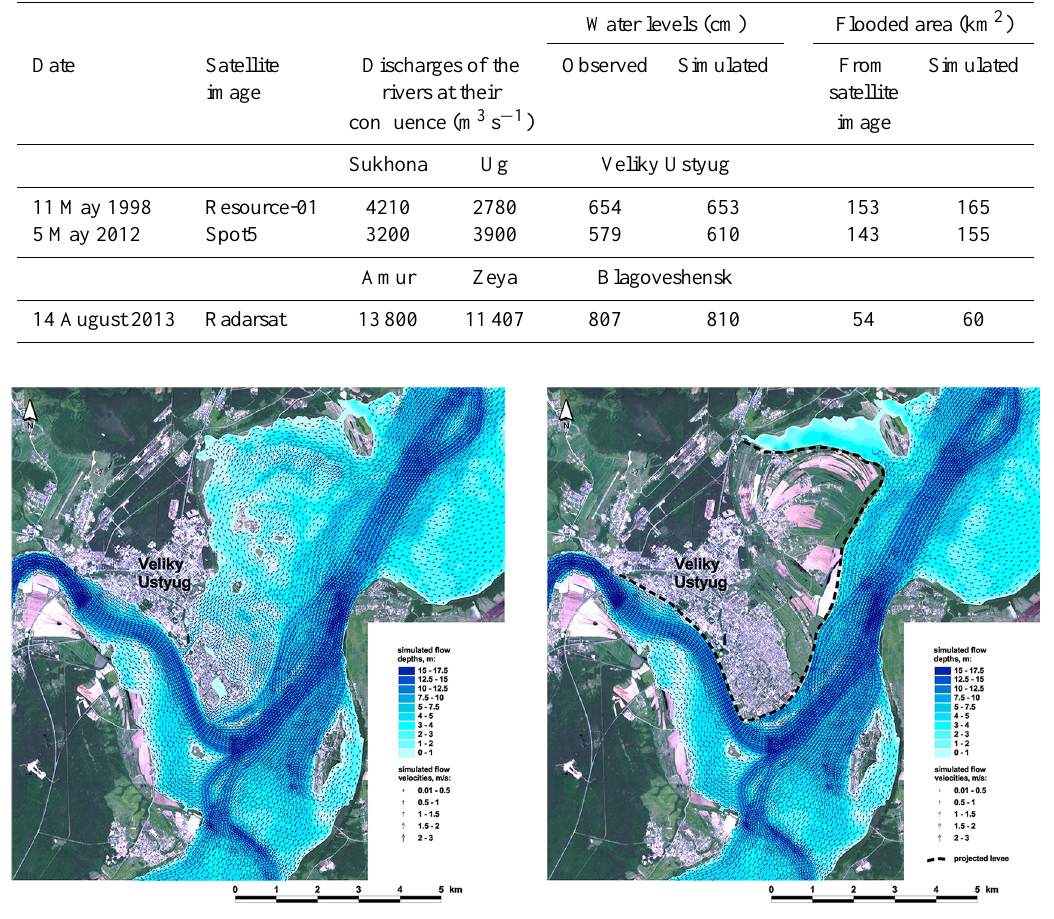
Figure 3. Simulated water depths and flow velocities at Veliky Ustuyg for the runoff induced flood of 1% exceedance probability: (a) for current conditions, (b) in case of levee